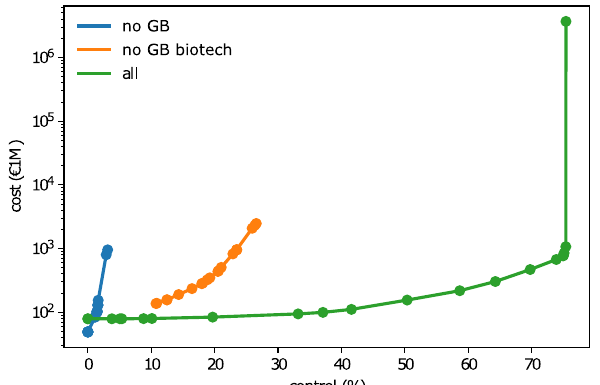
Figure 3. Control and cost for the target restricted control optimization. GB constraint ( no GB , in orange), for the GB biotech constraint ( no GB biotech , in blue), and for the unconstrained case ( all , in green). Control shows the % of total shares of the target nodes that the external agent controls. Note that not necessarily all shares of every company are available in the network (e.g. restricted shares). Cost is the monetary value that the agent spends to acquire a given control (in